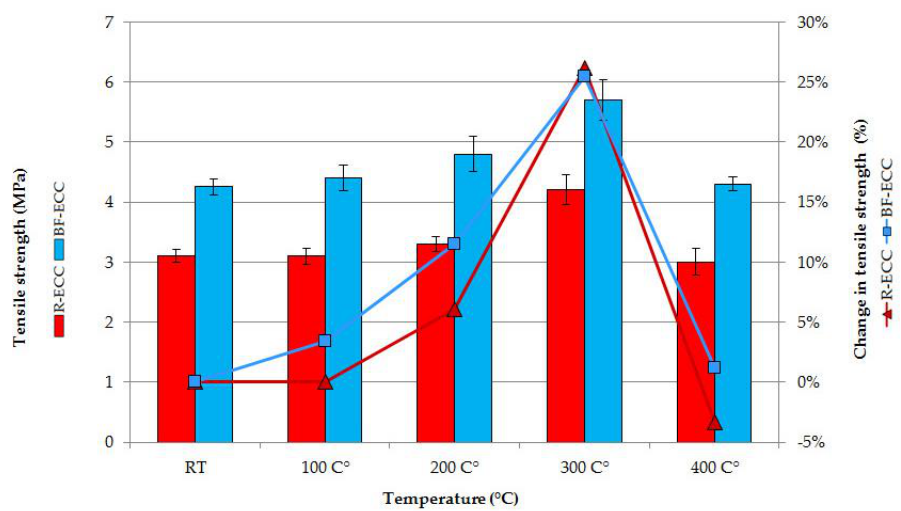
Figure 5. The result of the change in tensile strength of control and fiber-reinforced specimens exposed to elevated temperatures up to 400 °C.